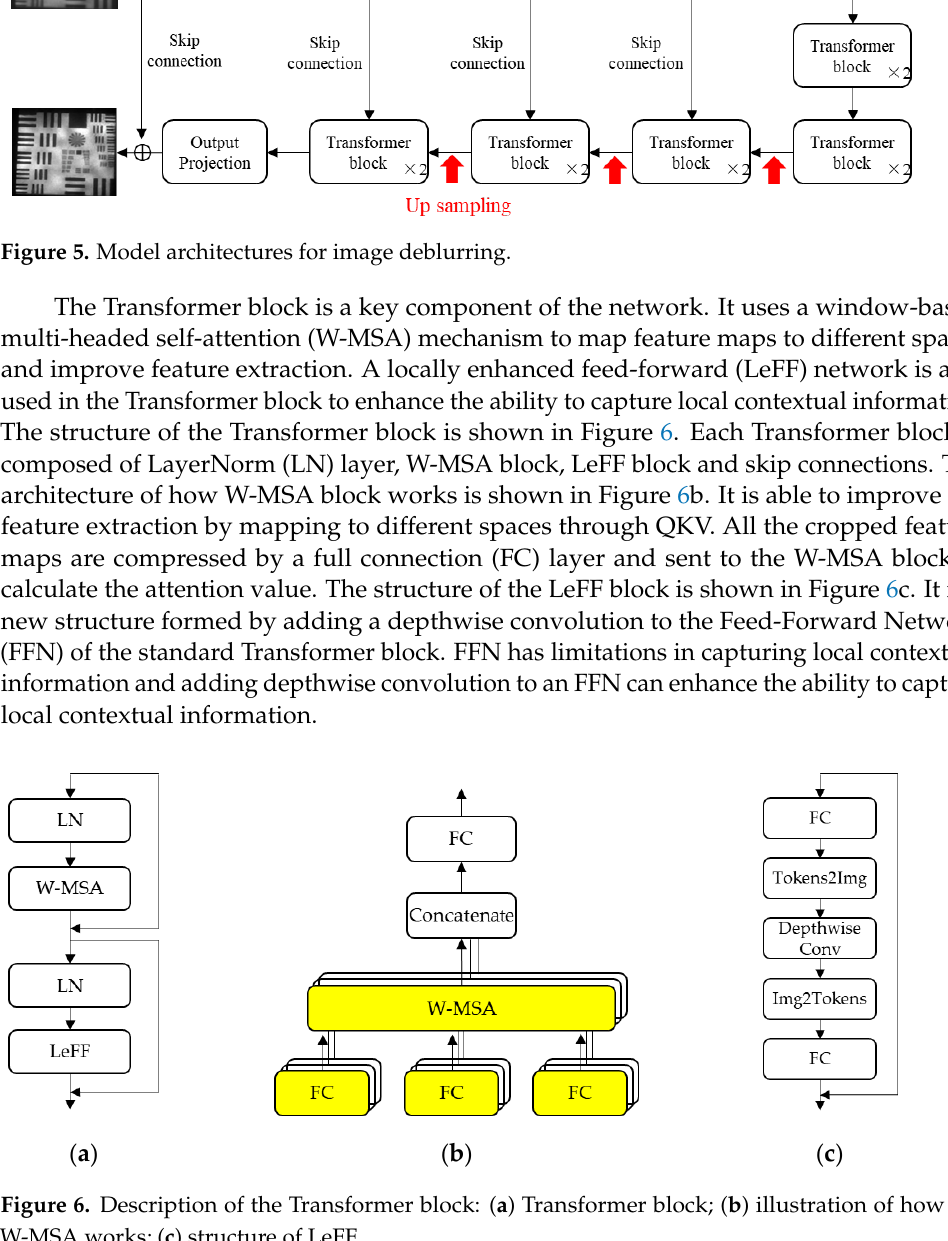
( c ) Figure 7. The PLRGI system and experimental scenario: ( a ) the PLRGI system used in the experi- ments: ( b ) water tank in lab; ( c ) boat tank.